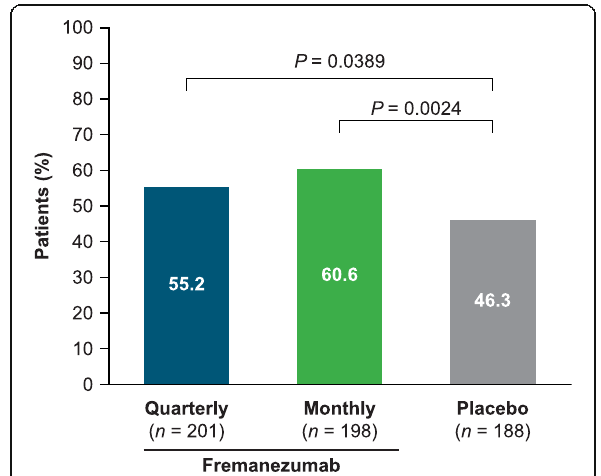
Fig. 3 Proportion of patients with CM who reverted from MO to no MO during the 12-week treatment period. CM, chronic migraine; MO, medication overuse